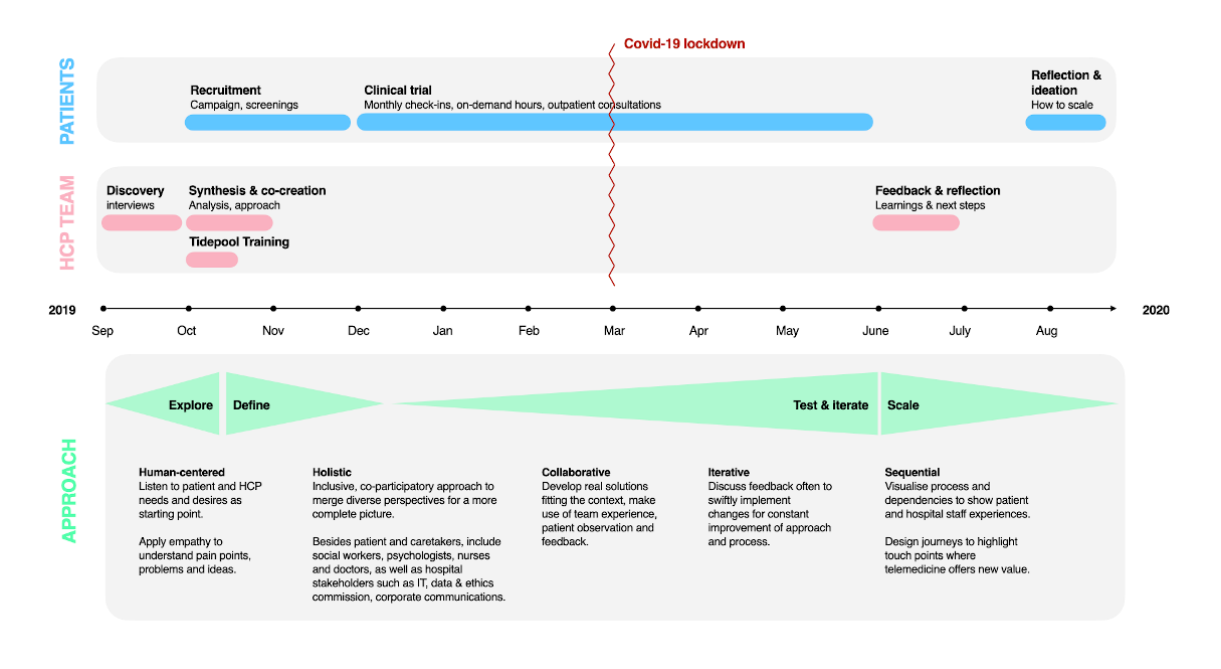
Figure 1. An overview of the methods that were used in this study; the interventions that involved the HCP team, patients, and caregivers; and